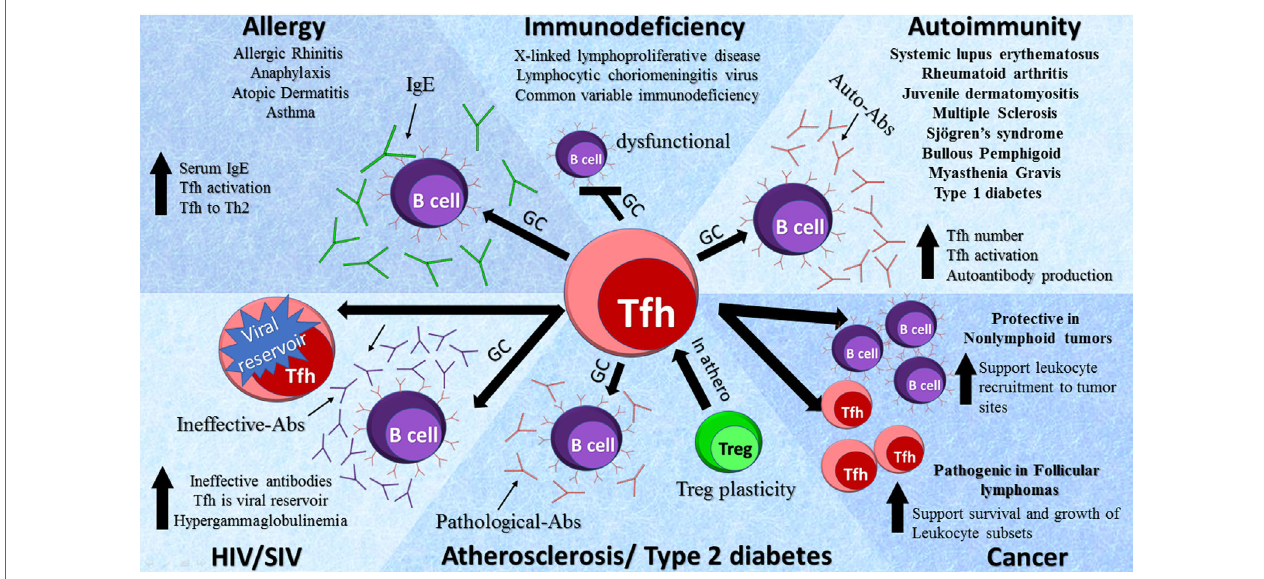
FigURe 2 | Role of T follicular helper (Tfh) cells in diseases. Tfh cells are involved in a variety of pathologies by diverse mechanisms as depicted in the schematic diagram. Elevated Tfh activity leads to an increase in germinal center (GC) formation, activity, and subsequent production of auto-Abs in autoimmune diseases. In primary immunodeficiencies, a decrease in Tfh cells has been detected with dysfunctional GC formation, whereas in acquired immunodeficiencies such as HIV and SIV an increase in Tfh cells serves as viral reservoirs. In atherosclerosis regulatory T cells (Tregs) transition to Tfh cells via GCs leading to the production of pathological Abs. In allergy, there is an increase in Tfh cell activation and GC formation causing the production of IgE. The role of Tfh cells in cancers is complex and dependent on the types of